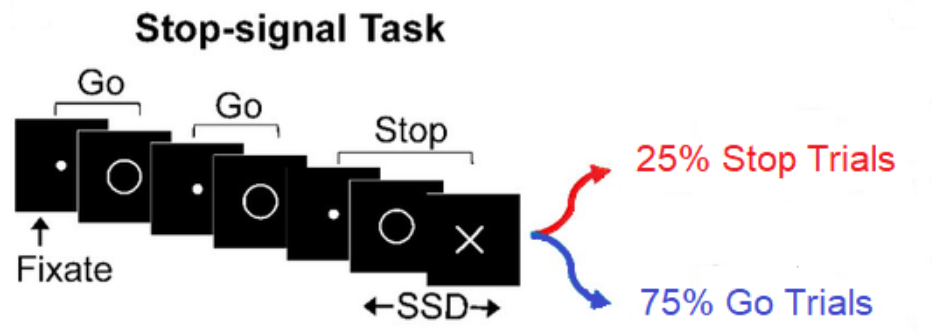
Figure 1. Standard Stop-signal Task (SSST) design with p ss = 0.25 including two versions of the task: